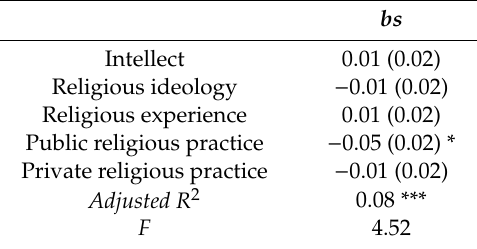
Table 2. Multiple regression analyses: Religiosity dimensions predicting impulsive